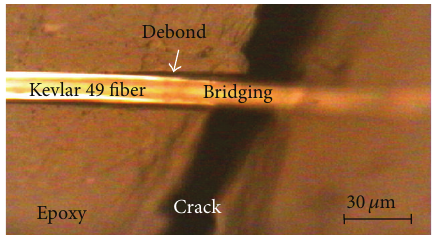
Figure 8: Bridging fiber and interfacial debonding during crack opening